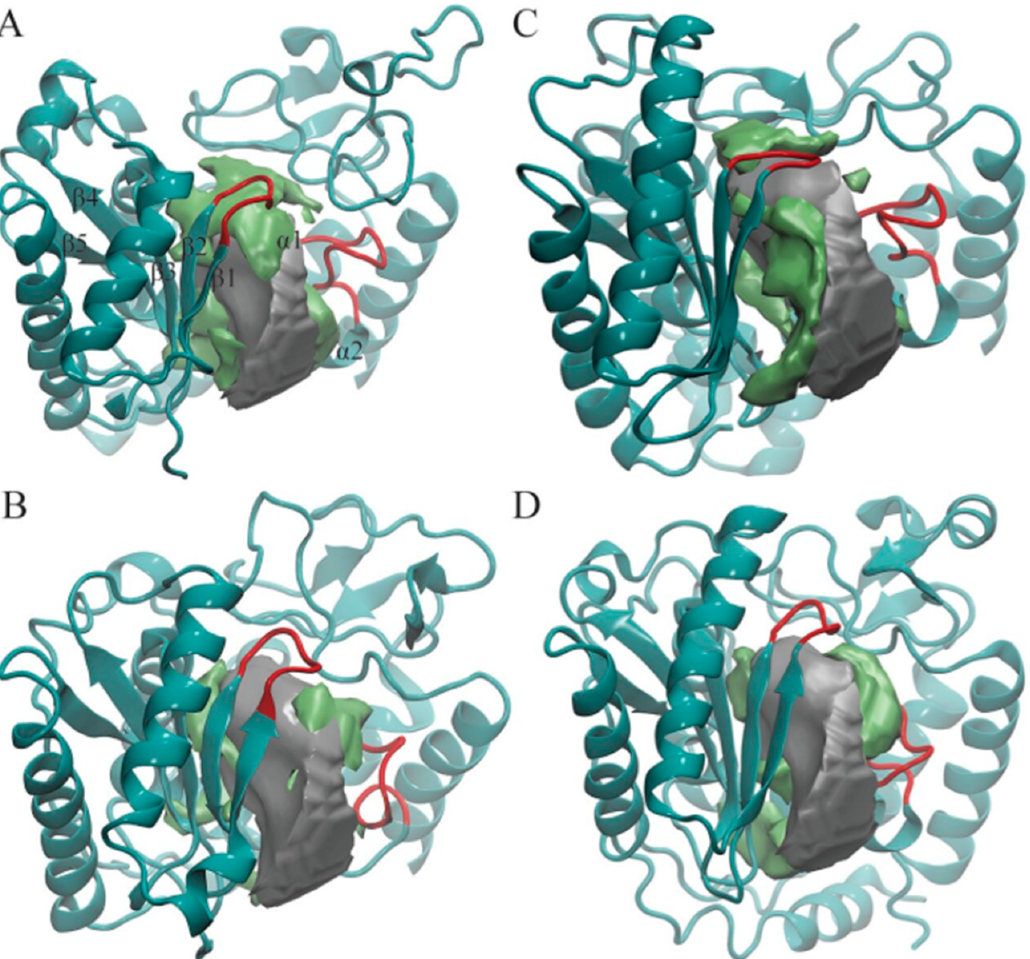
Figure 2. Pocket shapes of the most-populated four cluster centroids: ( A ) TbRET1; ( B ) TbRET2; ( C ) TbMEAT1; ( D ) TbTUT4. Only NTD and CTD are shown in cyan ribbons in each enzyme for clarity. The average pocket shape of all enzymes is shown as a silver surface, and the additional region opening only in that cluster are shown as a green surface. The two loops we found to modulate the pocket shape are highlighted with red. Beta-sheets and alpha-helices close to the active site are labeled on TbRET1 only ( α 1 labeled, but not visible).